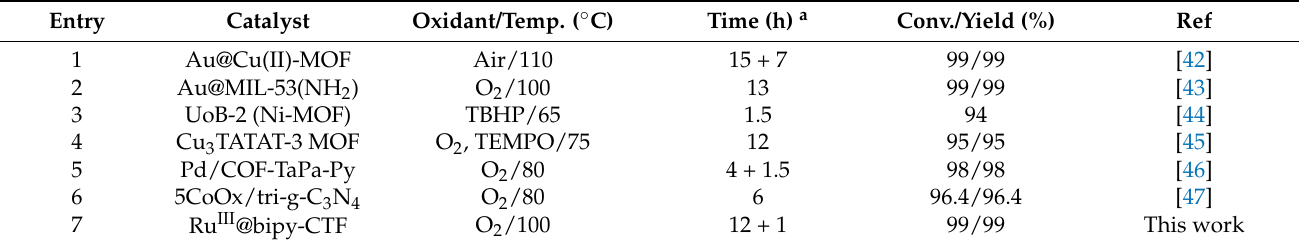
Table 4. Comparison of the Ru III @bipy-CTF catalyst with other heterogeneous catalysts for selective tandem oxidation- Knoevenagel condensation